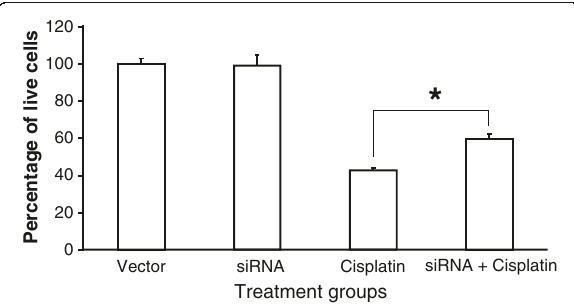
Figure 6 Effect of silencing of sFRP4 and subsequent Cisplatin treatment. Graphical representation of A2780 live cell number quantified following silencing of sFRP4 and subsequent Cisplatin treatment for 24 hours. (* p < 0.001; one way ANOVA and